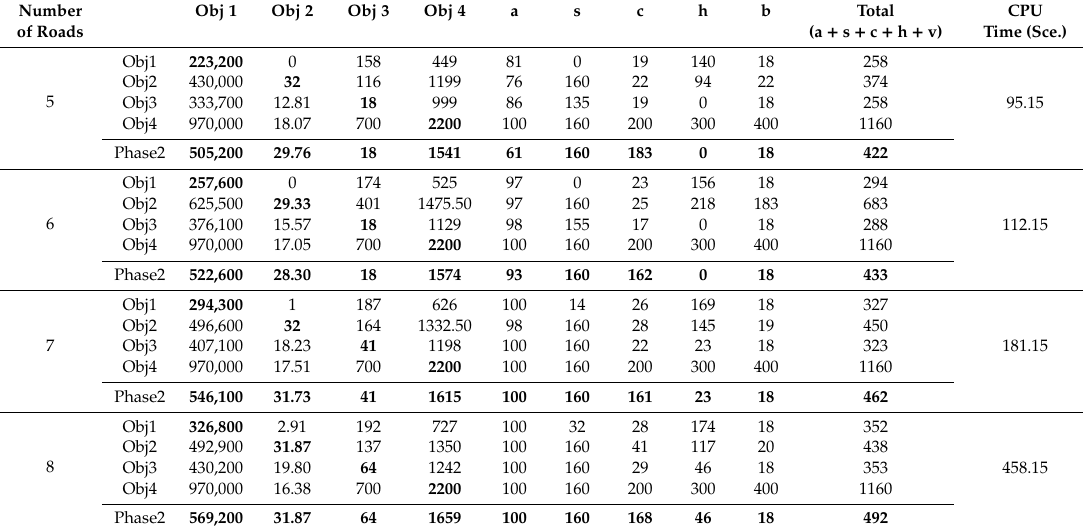
Table A1. Optimal allocation with increasing number of road segments using two-phase